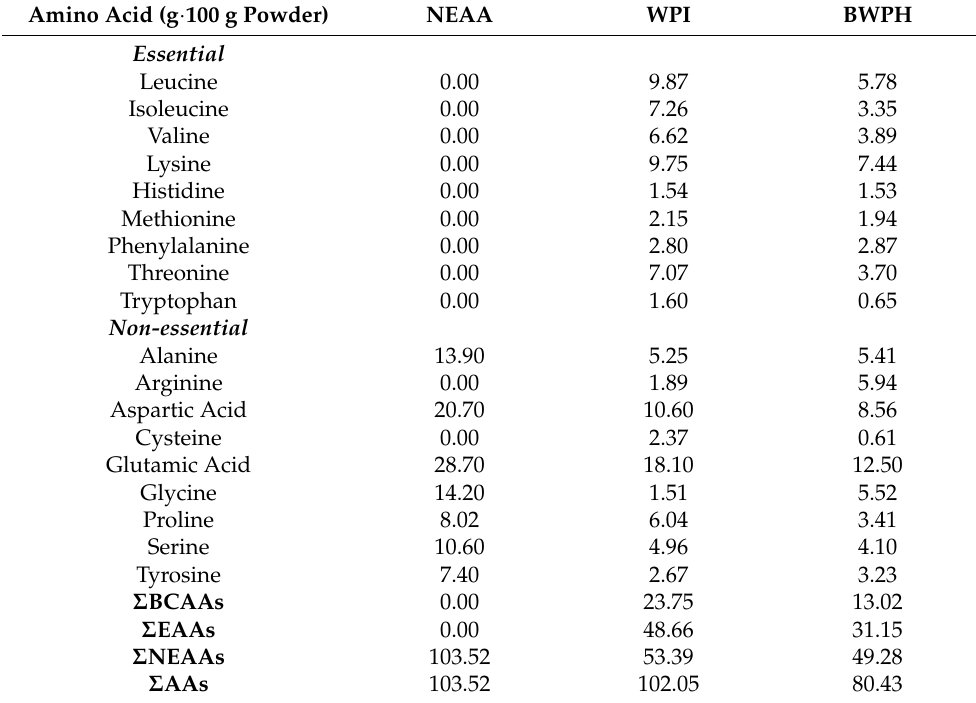
Table 1. Amino acid composition of the negative control (NEAA), positive control (WPI), and BWPH